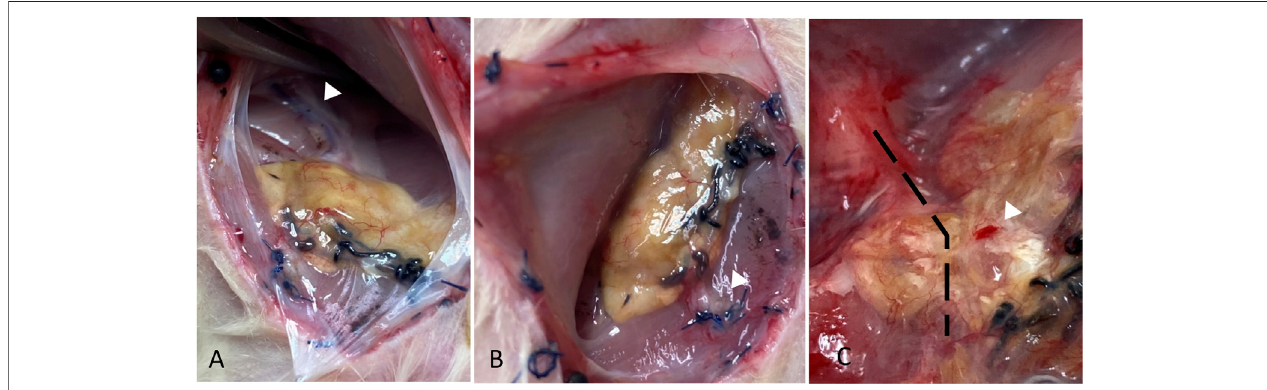
FIGURE 5 | Gross morphology of the liver at the study end-point showing the AV bundle proximal and distal to the scaffold (white arrowheads in A and B , respectively), surface vascularization, and bleeding on touch (white arrowhead in C ). The location of AV bundle in ( C ) is marked by a dashed line.